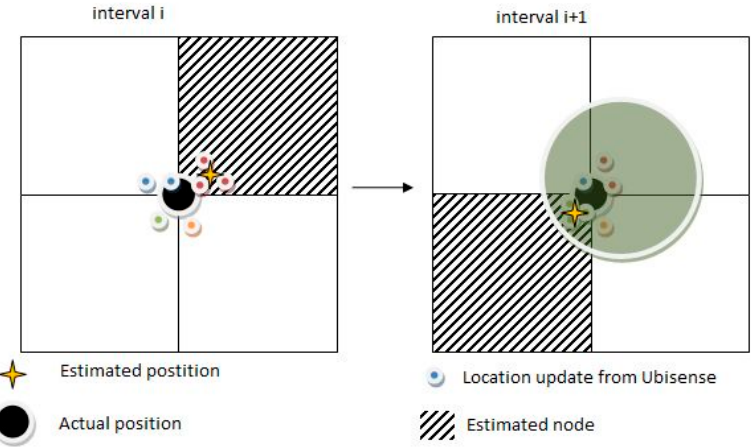
Figure 3. Movement detection. User is standing over the boundary between nodes, no movement is